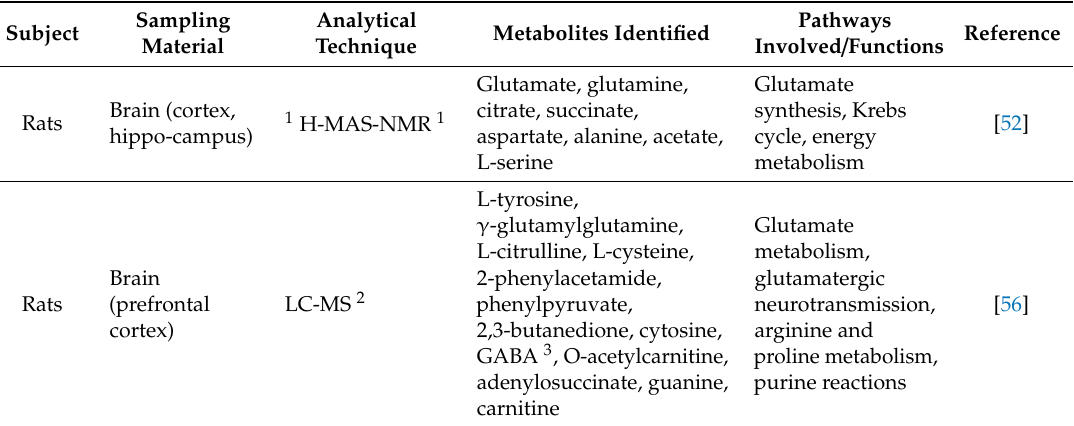
Table 3. Possible biomarkers identified in animal-based studies of